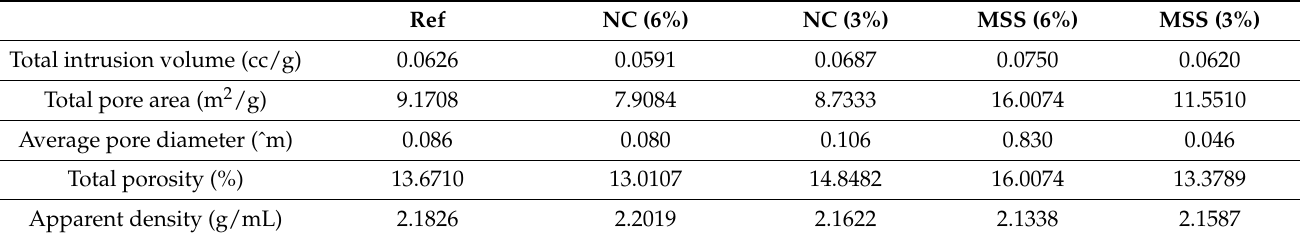
Table 2. Porosimetric analysis.